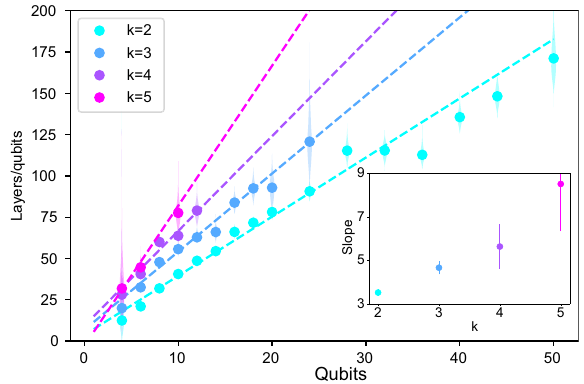
Fig. 7 Layer/qubits scaling as a function of the number of qubits for the local random unitary ansätz. Missing data points are due to insuf fi cient data (see the Supplementary Discussions 3.1 for more details). The inset shows the fi tted slopes for different k values. Error bars show one standard